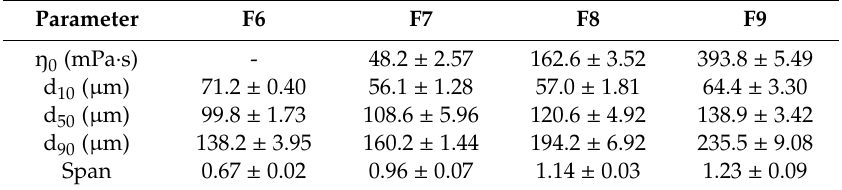
Table 3. Zero shear viscosity of spraying suspensions and particle size parameters of the PLGA MS (F6–9).